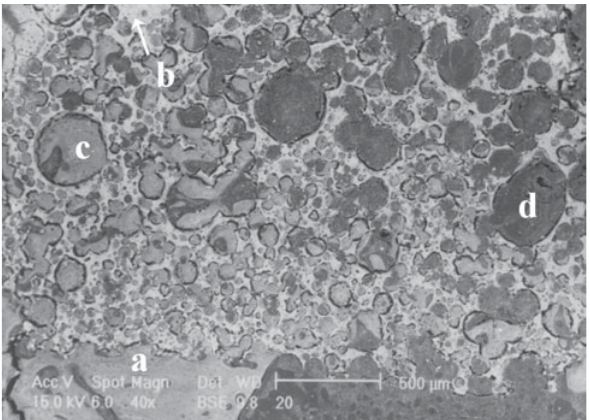
Figure 3a. Section of HA foam implant after 8 weeks, showing osteointegration and extensive bone ingrowth in within the pore and connections of the structure. The original bone is shown in (a), the porous implant appear in light coloured areas (b), whereas new bone tissue appears in light grey (c) and collagen in dark grey (d).